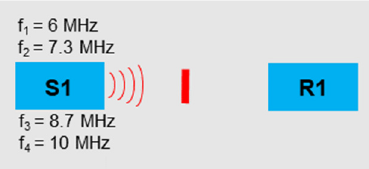
Figure 20. Excitation frequencies: f 1 = 6 MHz, f 2 = 7.3 MHz, f 3 = 8.7 MHz, f 4 = 10 MHz.